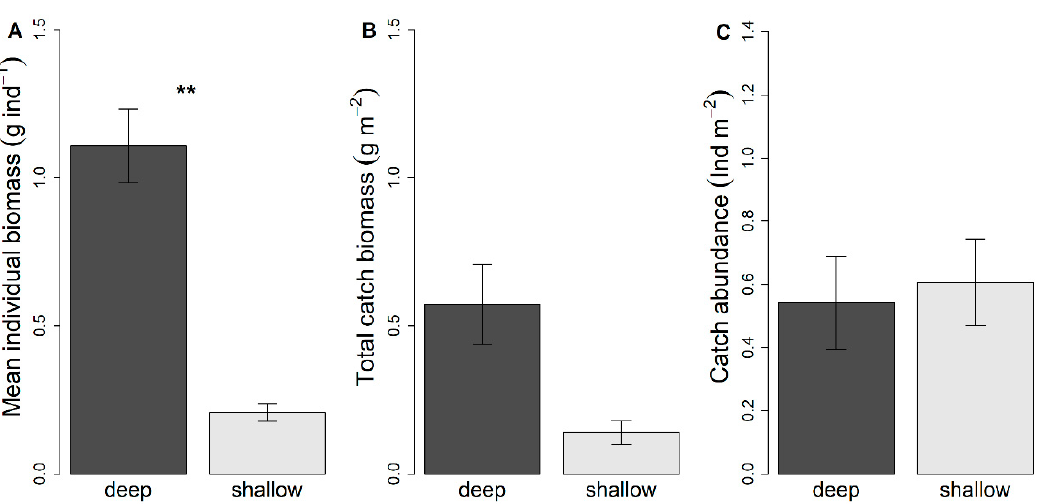
Figure 2. Nekton individual biomass, total biomass per unit effort (BPUE) and catch per unit effort (CPUE) comparisons between deep and shallow meadows. Changes in: ( A ) individual biomass (g ind − 1 ), ( B ) total catch BPUE (g m − 2 ), and ( C ) CPUE (ind m − 2 ). Individual biomass differed significantly between depths ( p = 0.01), indicated by ** on Panel A.